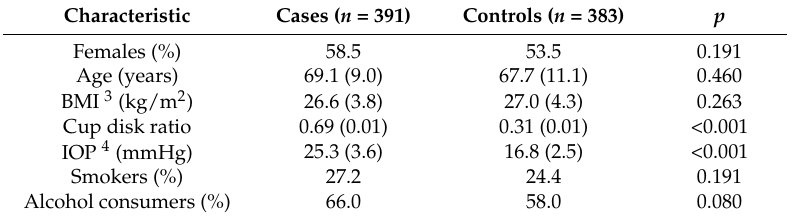
Table 1. Sociodemographic and clinical characteristics of POAG 1 cases and controls 2 .